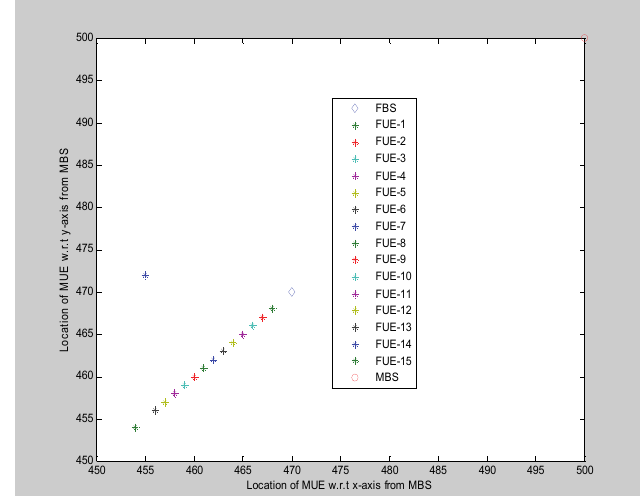
Fig. 7. Location of FUEs w.r.t. FBSs.